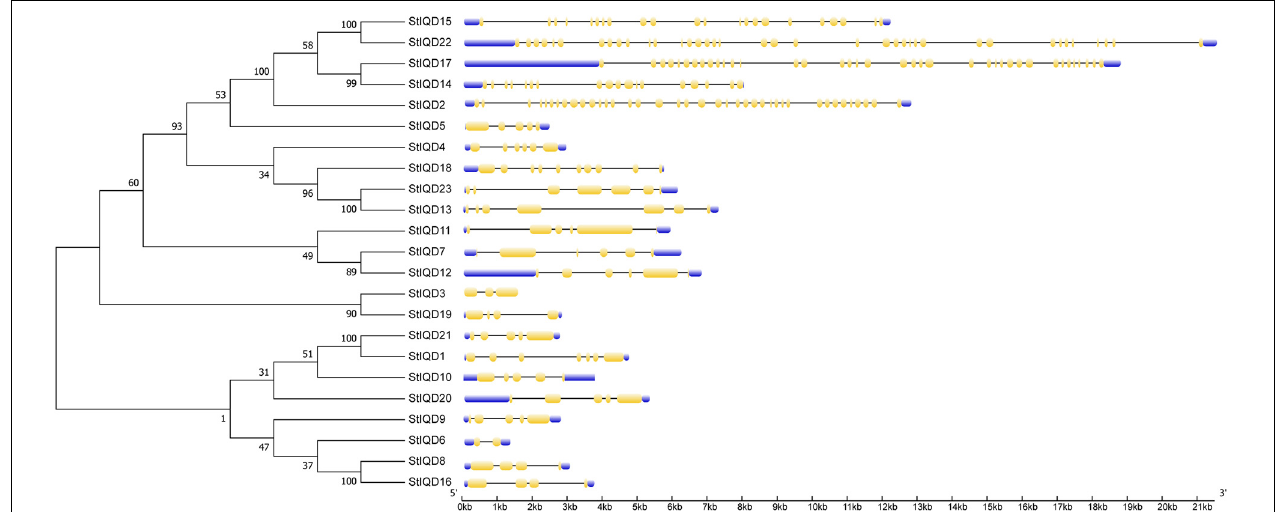
FIGURE 2 | Phylogenetic analysis and exon–intron organization of StIQD . Maximum likelihood trees of full-length amino acid sequences encoded by StIQD (left) and exon–intron organization of StIQD (right). Exons: yellow boxes; introns: black lines; Untranslated regions: blue box.